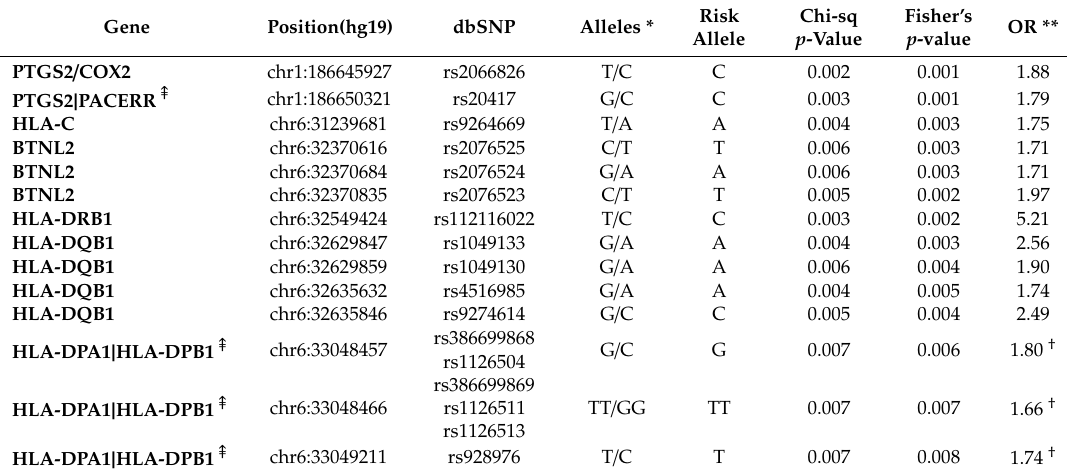
Table 3. Genetic variants most associated with sarcoidosis.